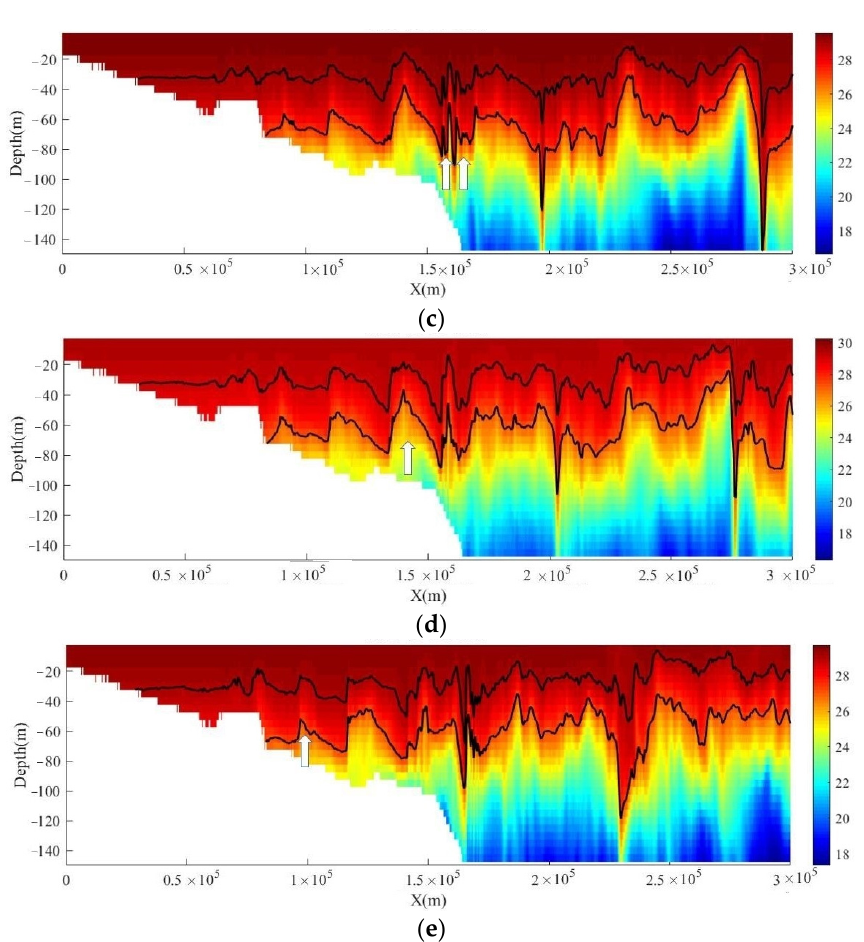
Figure 7. The isotherm of internal waves propagating on the continental slope along cross-section P1 during May 2018, ( a ) 23:00 13rd, ( b ) 07:00 14th, ( c ) 15:00 14th, ( d ) 03:00 15th, ( e ) 23:00